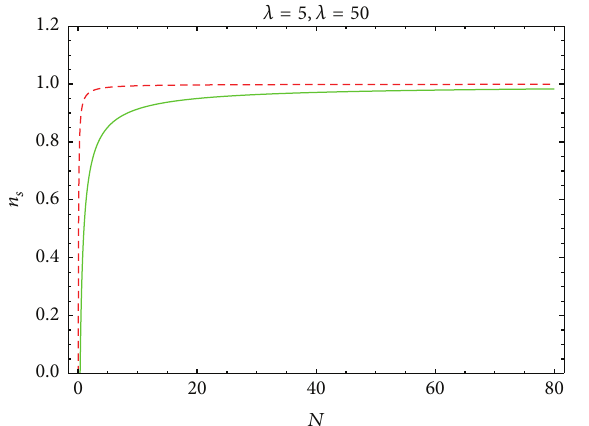
Figure 10: Spectral index in terms of number of e-folds, ] = 50 by dashed line and ] = 5 by green line.